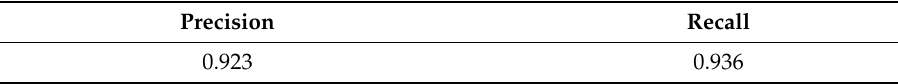
Table 3. The numerical result of 19 tests for